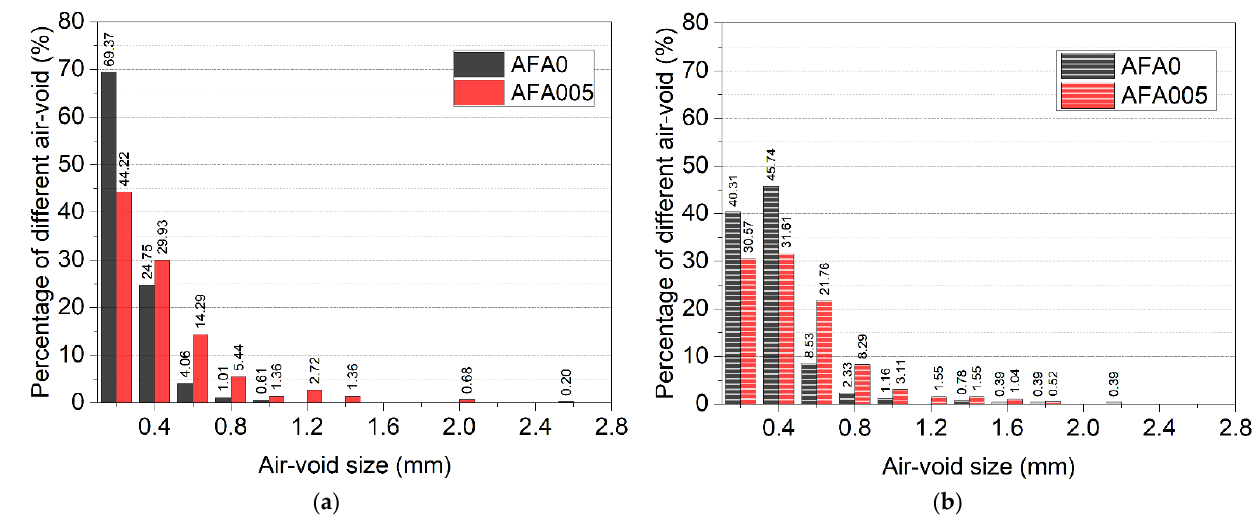
Figure 8. Air-void size distribution of mortar at 28 days. ( a ) Mould cast samples, ( b ) 3D printed samples.